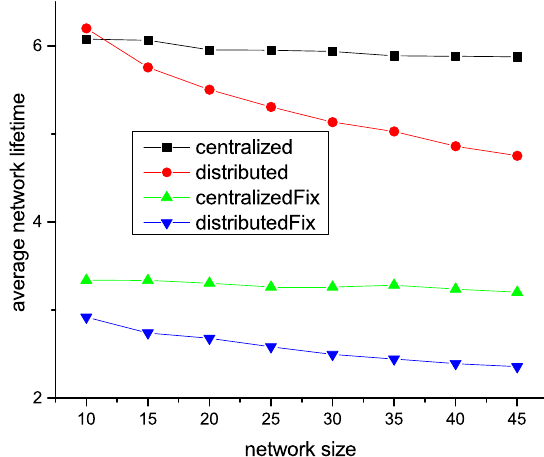
Figure 5. Network lifetime vs. network size with different sink selection algorithms.